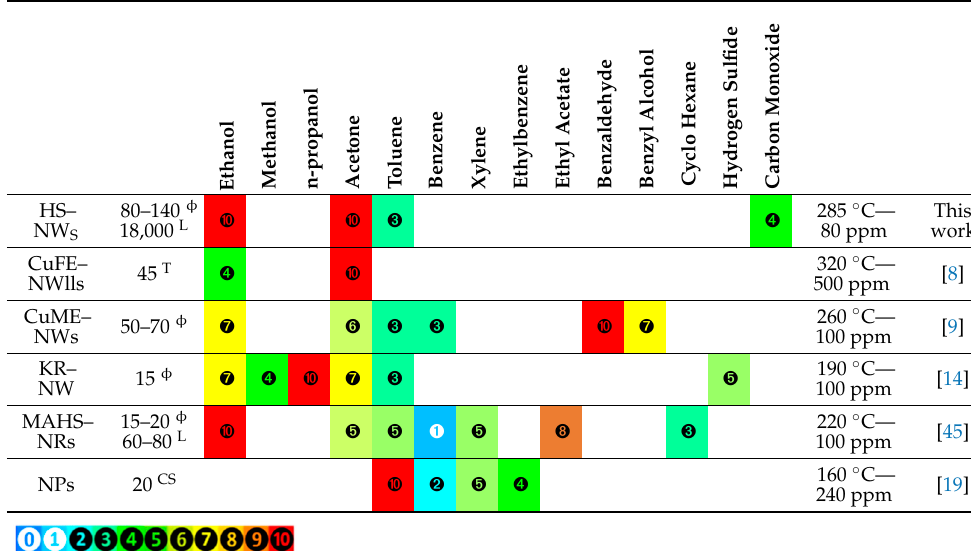
labeled as 10). Thus, for instance, the first row displays our results and indicates that the hydrothermally synthesized CuO nanowires respond preferentially to acetone and ethanol (both in red color 10) instead of carbon monoxide (green 4) and toluene (cyan 3), which comparatively present lower responses. The literature reports corroborate this fact by showing noteworthy sensitivities to acetone [8,9,14] and ethanol [47]. However, they also suggest the relevance of CuO as a good candidate to sense n-propanol [14], toluene [19], and benzaldehyde [9], suggesting these gases may have high cross-responses among them and with acetone and ethanol. Table 1. Comparative table showing the cross-responses to various reducing gases recorded using CuO. The color codes and numbers in each row of the table represent the load of response for the referenced material towards the same gas concentration of various tested analytes.